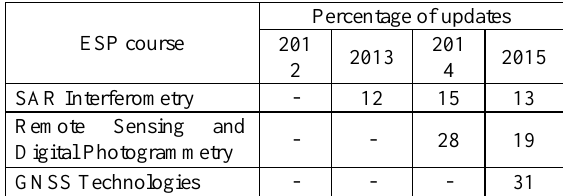
Table 6. Percentage of annual updates of the ESP manuals The software source files with active vocabulary and key phrases of the units may be easily rearranged in any text